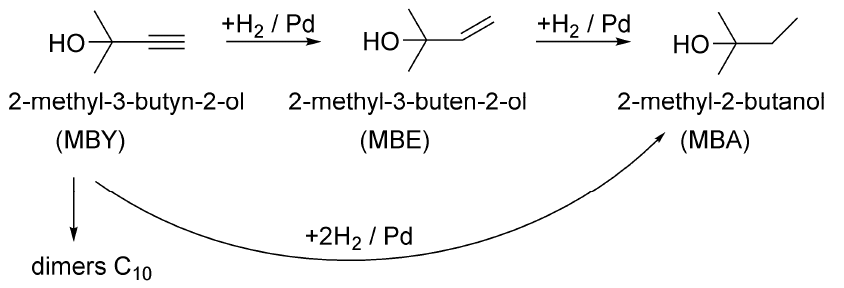
Figure 4. Scheme of the 2 ‐ methyl ‐ 3 ‐ butyn ‐ 2 ‐ ol (MBY) hydrogenation reaction.